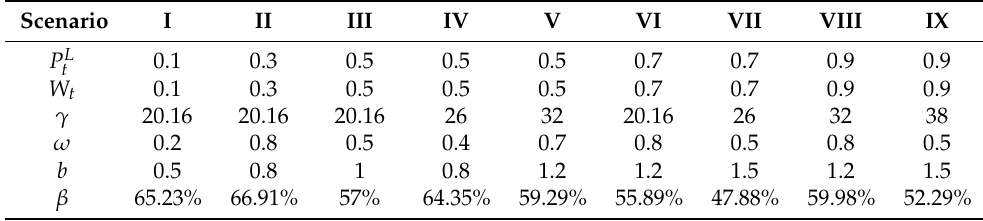
Table 4. OPPSC in different